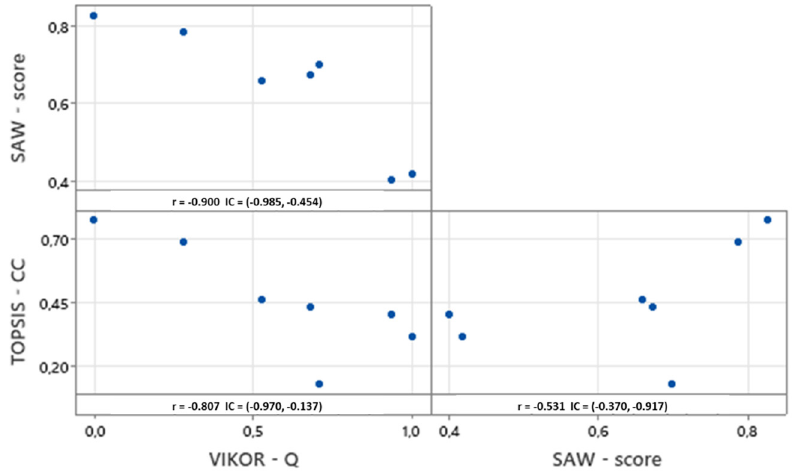
Figure 7. Pearson correlation results (confidence interval = 95.0%).